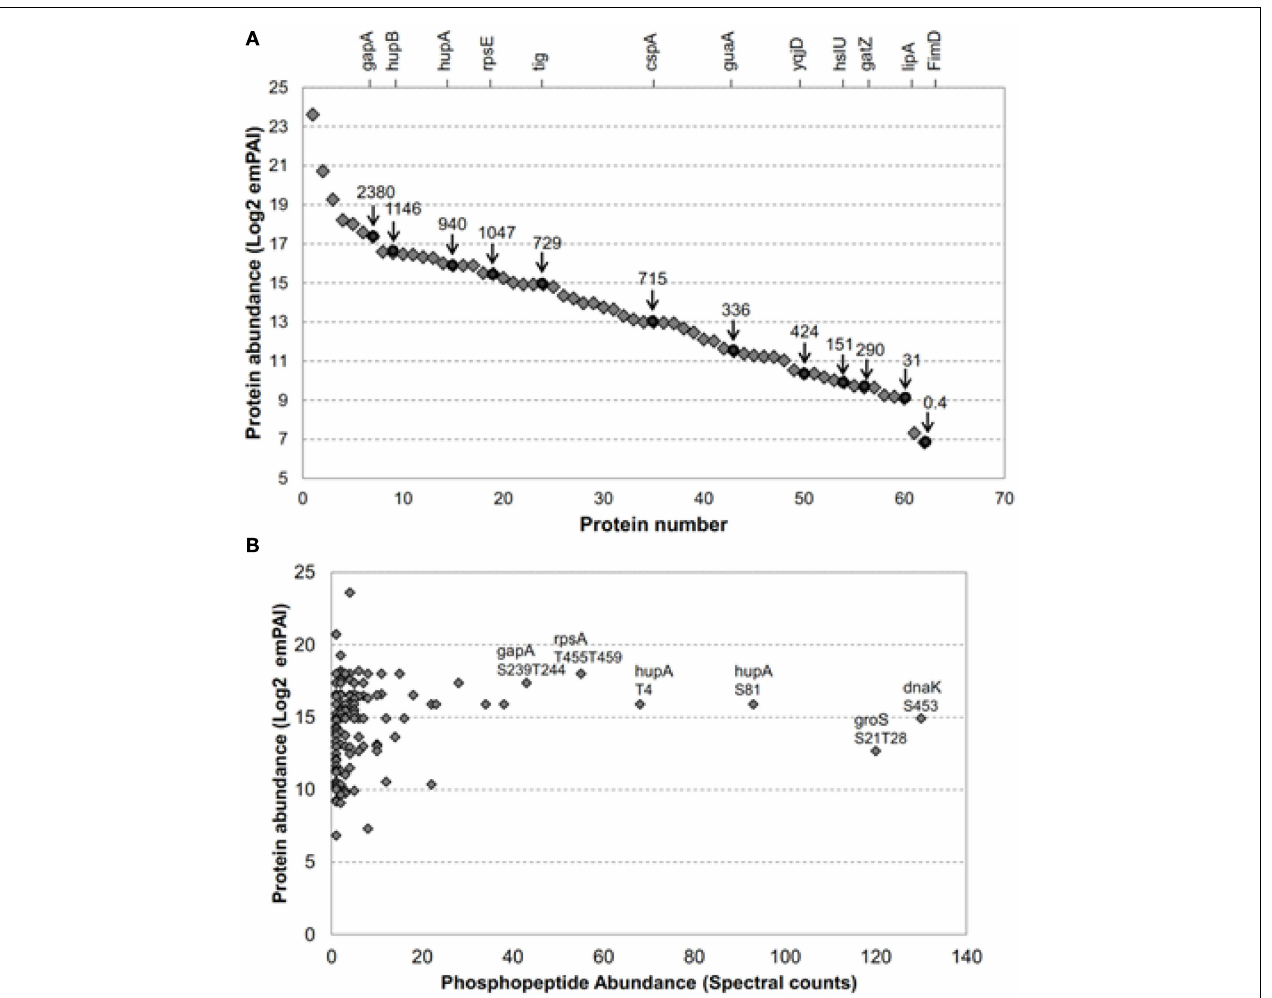
(27) rplJ; (28) grpE; (29) rpmA; (30) frr; (31) rpsJ; (32) rplK; (33) rpsl; (34) cspA; (35) rpsK; (36) sucB; (37) rpoA; (38) groS; (39) pnp; (40) rho; (41) rpoC; (42) juaA; (43) typA; (44) ybeD; (45) infB; (46) sucD; (47) pta; (48) ihfB; (49) yqjD; (50) rpoD; (51) ihfA; (52) aspA; (53) hslU; (54) ftsZ; (55) gatZ; (56) dnaJ; (57) accD; (58) lipA; (59) gatD; (60) tatA; (61) parB; (62) FimD. (B) Abundance of specific phosphopeptides, derived from E. coli proteins transphosphorylated by BRI1 in situ , was not related to the abundance of the parent protein.The spectral counts were the sum of four independent experiments, two with TiO 2 enrichment and two with IMAC (Fe 2 + ) enrichment.The phosphopeptides with top spectral counts are annotated in the